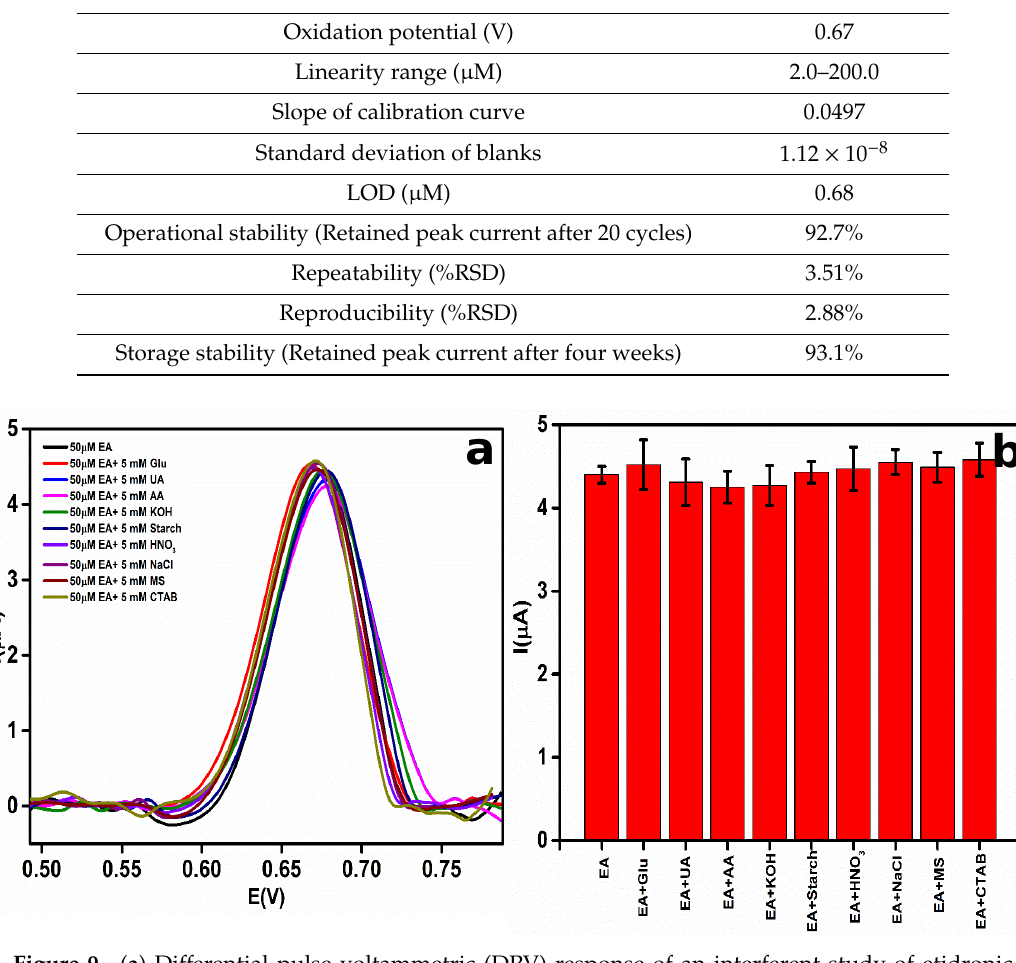
Table 2. Interference study results in the electrochemical detection of EA.